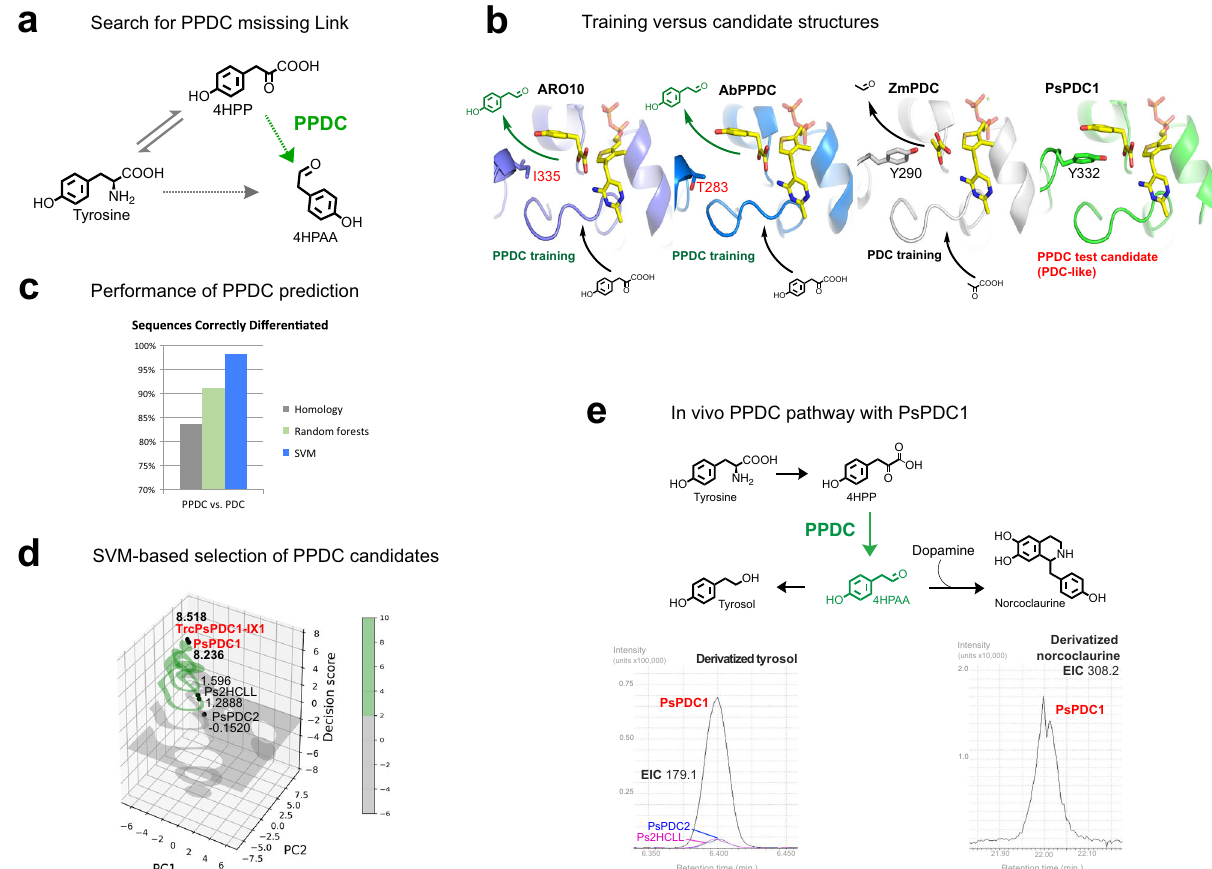
Fig. 4 PsPDC1 promotes an alternative branch to 4HPAA for norcoclaurine production. a The PPDC branch pathway (green) can produce 4HPAA via 4HPP, and this missing link is also unreported in P. somniferum . b Structural comparison of classi fi ed phenylpyruvate decarboxylase (PPDC) enzymes ARO10 (purple), Azospirillum brasilense PPDC (AbPPDC, PDB ID: 2Q5O [https://www.rcsb.org/structure/2Q5O], blue) in comparison to typical Zymomonas mobilis pyruvate decarboxylase (PDC) (ZmPDC, PDB ID: 2WVA [https://www.rcsb.org/structure/2WVA], grey) and candidate PPDC sequence PsPDC1 (green). The modeled PsPDC1 active site contains Y332, which is also present in typical PDC enzymes which decarboxylate pyruvate. In this respect, the PsPDC1 active site is distinct from microbial PPDCs, which all contain smaller residues (red) in place of Y332 ( Lactococcus lactis KdcA contains S286 corresponding to Y332). Yet, the presence of Y332 in PsPDC1 does not interfere with the docking of tyrosine into the PsPDC1 active site. c Cross-validation for correct assignment of PPDC model training sequences is performed using SVM models (blue), Random forests models (green), and by comparing sequence homology of each training sequence to a consensus sequence of PPDC training sequences and a consensus sequence of PDC training sequences (grey), as described in the methods section. d SVM-based prediction of putative PPDC sequences visualized in three dimensions by compressing high-dimensional data (Supplementary Table 3, upper table) into two dimensions (PC1 and PC2) and plotting them together with two-dimensional decision scores. Prediction spaces with two-dimensional decision scores above and below 2 are colored green and grey, respectively. Prediction score trends for truncated PsPDC1 isoform X1 (TrcPsPDC1-IX1, red), PsPDC1 (red), PsPDC2 and Ps2HCLL (2-hydroxyacyl-CoA ligase-like) are similar in high dimensional models (Supplementary Table 3). e PsPDC1 mediates in vivo production of 4-hydroxyphenylethanol (tyrosol) through a 4HPAA intermediate (green), in M9 medium supplemented with 1.2mM 4HPP at 25°C with 180rpm shaking. Strain P1-01-AI, which contains PsPDC1 (red), mediates higher tyrosol production than that of strains P2-01-AI and P3-01-AI, which contain PsPDC2 (blue) and Ps2HCLL (magenta), respectively. PsPDC1 (red) mediates downstream production of norcoclaurine (NC) from LB supplemented with 5mM tyrosine and 3.7mM dopamine in strain P1-02-AI, at 20 – 25°C with 180rpm shaking. Here, tyrosol is detected after 71h, and norcoclaurine is detected after 41h, from fi ltered and dried culture medium as trimethylsilyl (TMS)-derivatives using GC-MS, as shown in the extracted ion chromatograms (EICs). Detection of PsPDC1 products is replicated in Supplementary Fig.